Question: Based on the figure, does the quantity rise or fall?
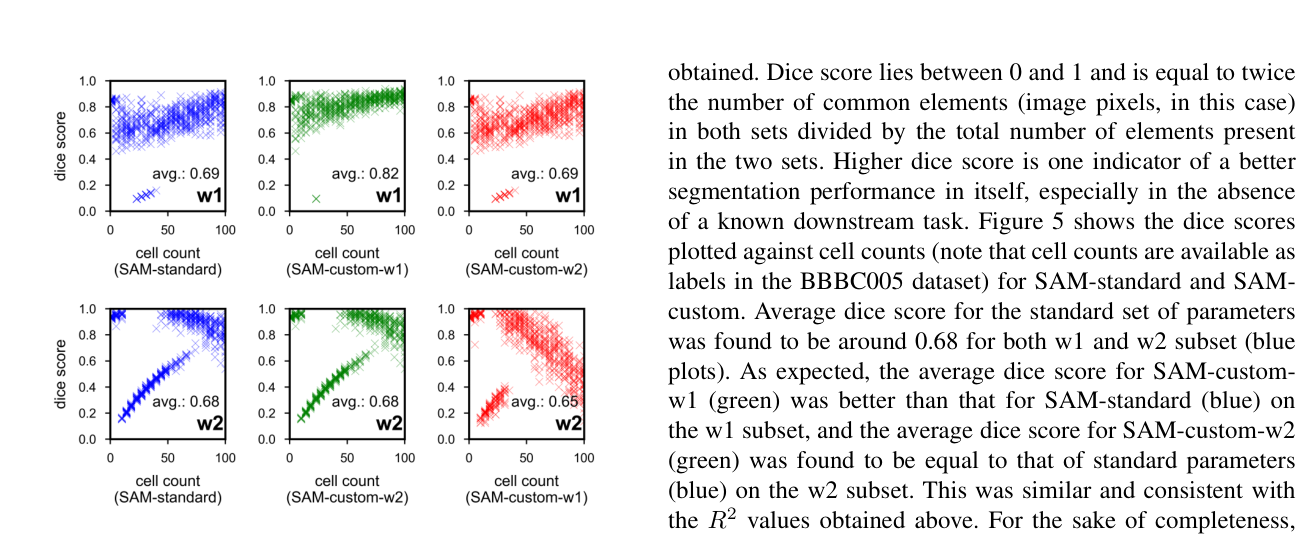
Answer: increasing